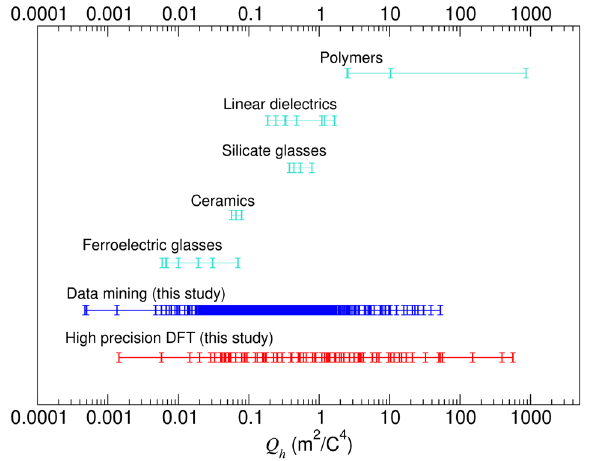
Fig. 2 Comparison of Q h electrostrictive coef fi cient between different materials classes. Magnitude of Q h values obtained from experiments (data taken from ref. 3 ) and compared to Q proxy Q DFT from our study. h